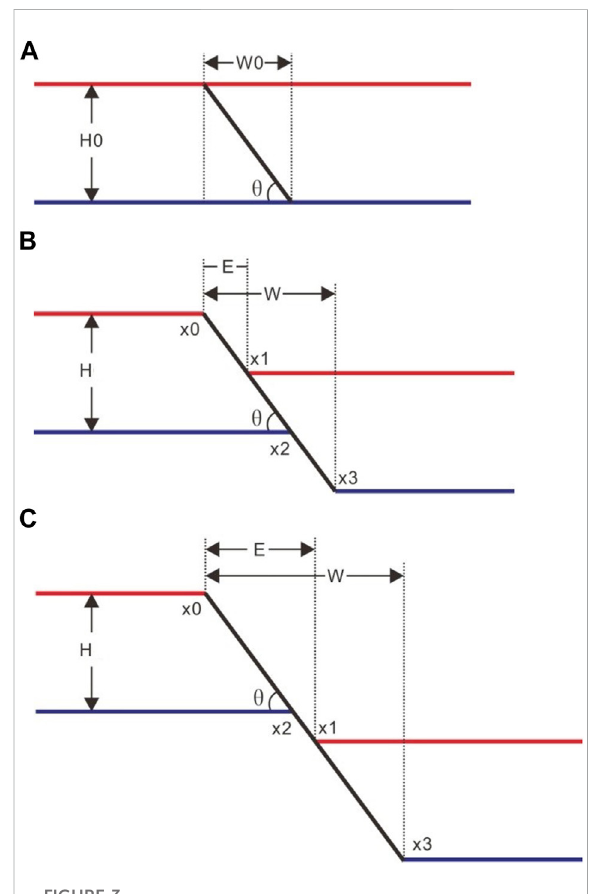
FIGURE 3 2Dmodelsketchtoshowthedeformationofnormalfault. (A) The initial (Andersonian) fault break. (B) Brittle layer displaced and connected. (C) Brittle layer displaced and disconnected, where H 0 is the initial layer thickness, θ is fault dip, E is extension amount, W is fault deformation width, W 0 is the initial width and x 0 to x 3 are horizontal co-ordinate of breakpoints, respectively. To simplify, the fl exure response to gravity and loads is not showing. These equally apply to both brittle curved faults and bending layers, and do not affect the formula